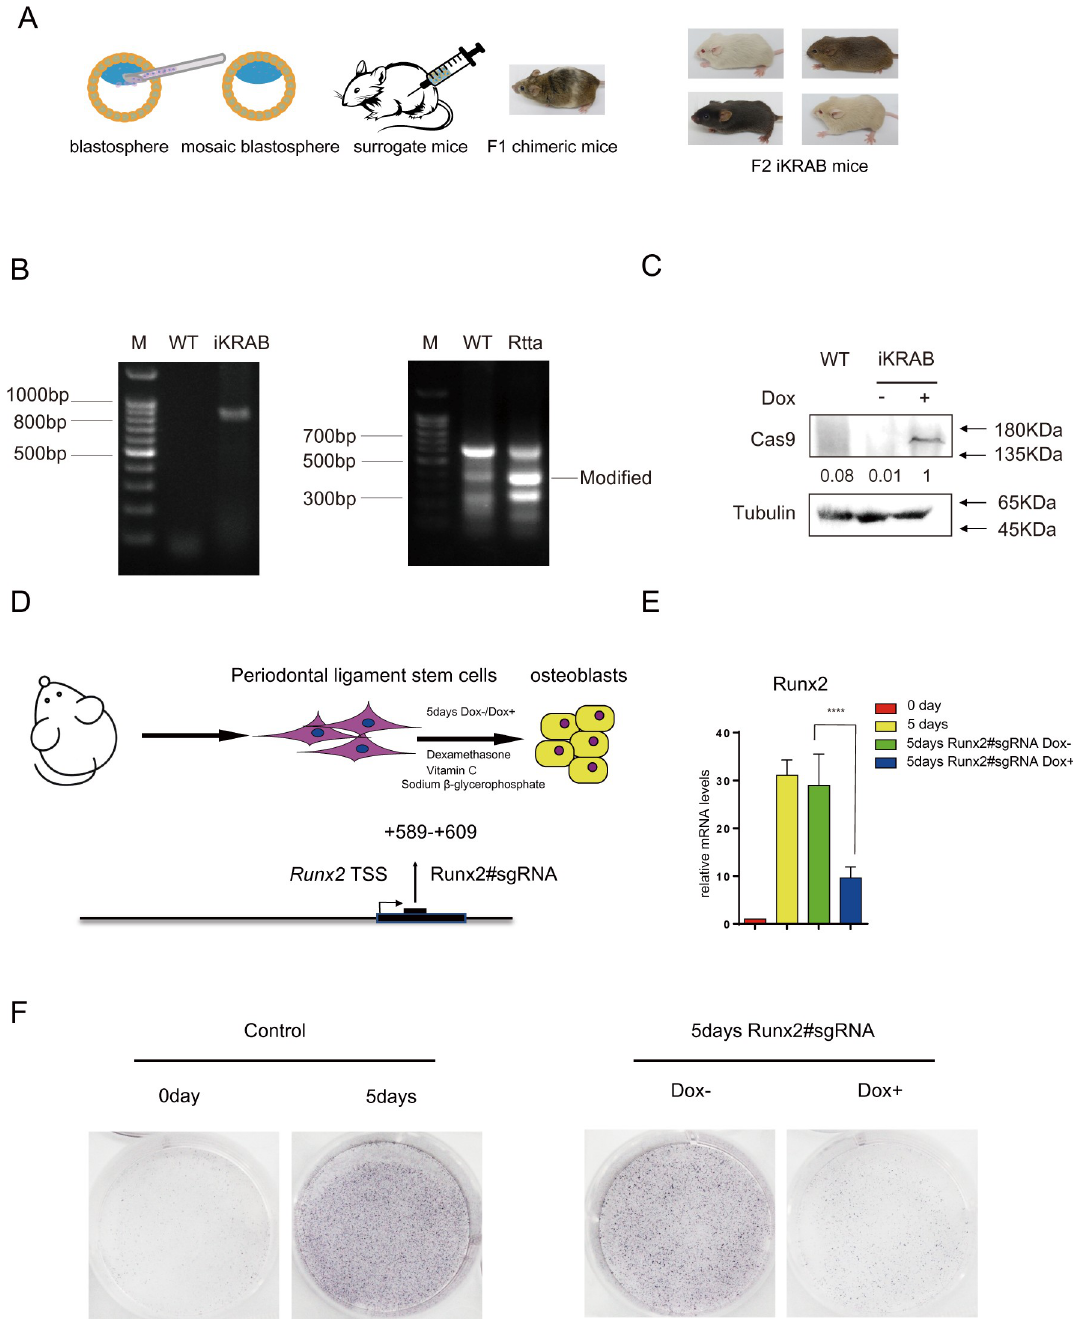
Fig 6. Characterization of the iKRAB KI mouse and ex vivo effect. (A) Schematic diagram shows the generation of iKRAB KI mice. (B) Genotyping PCR analysis of TRE-dCas9-KRAB and rtTA in WT and KI mice. (C) Western blot analysis of dCas9-KRAB expression in WT and iKRAB mice. β -tubulin served as a loading control. A relative gray value quantification of dCas9-KRAB protein levels is below each lane of the band. (D) Schematic diagram shows that PDLSCs from the iKRAB KI mice were introduced with sgRNA against the TSS of Runx2 , followed by differentiation into osteoblasts. (E) RT-qPCR analysis showing Runx2 mRNA levels in the designated groups. Data are represented as the mean ± SD of replicates ( n = 3) ( ���� p < 0.0001; and 2-tailed unpaired t test). (F) ALP staining of cells from the designated groups. The numerical values used to generate graphs in panel E are available in S1 Data. ALP, alkaline phosphatase; KI, knock-in; PLSC, periodontal ligament stem cell; rtTA, reverse transcriptional activator; RT-qPCR, reverse transcription PCR; SD, standard deviation; sgRNA, single-guide RNA; TSS, transcription start site; WT wild type.